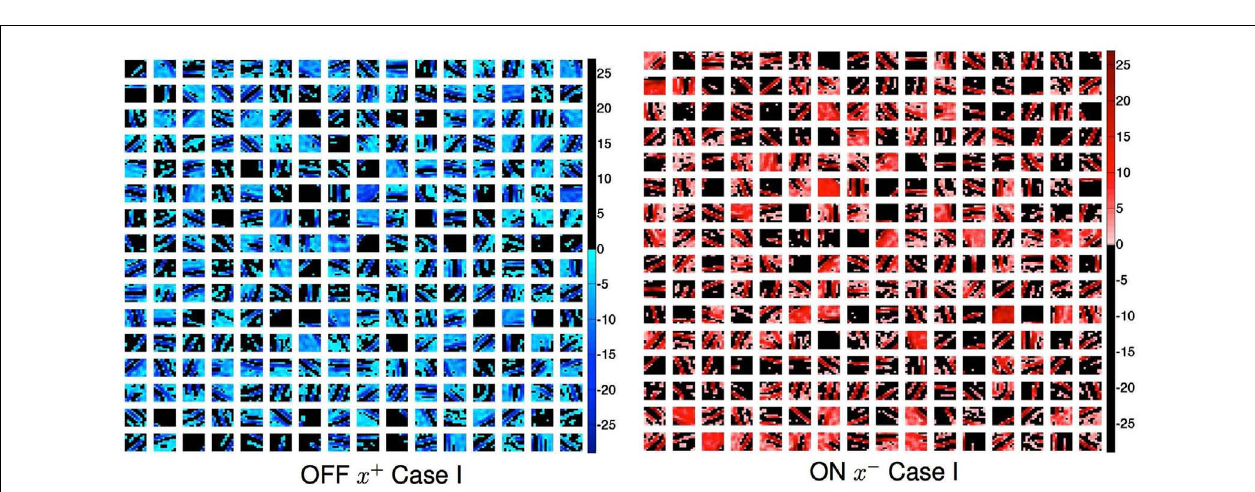
FIGURE 5 |The feedback pathway connections. (A) An inhibitory feedback circuit is simple to describe with signed synapses and signals. (B) Special care must be taken when using signed labeled lines. Analyzing the feedback to a single cell requires treating x + separately from x − , but here only the three cases for x + are analyzed as the cases for x − are symmetric. (B 1 ) Case I: in